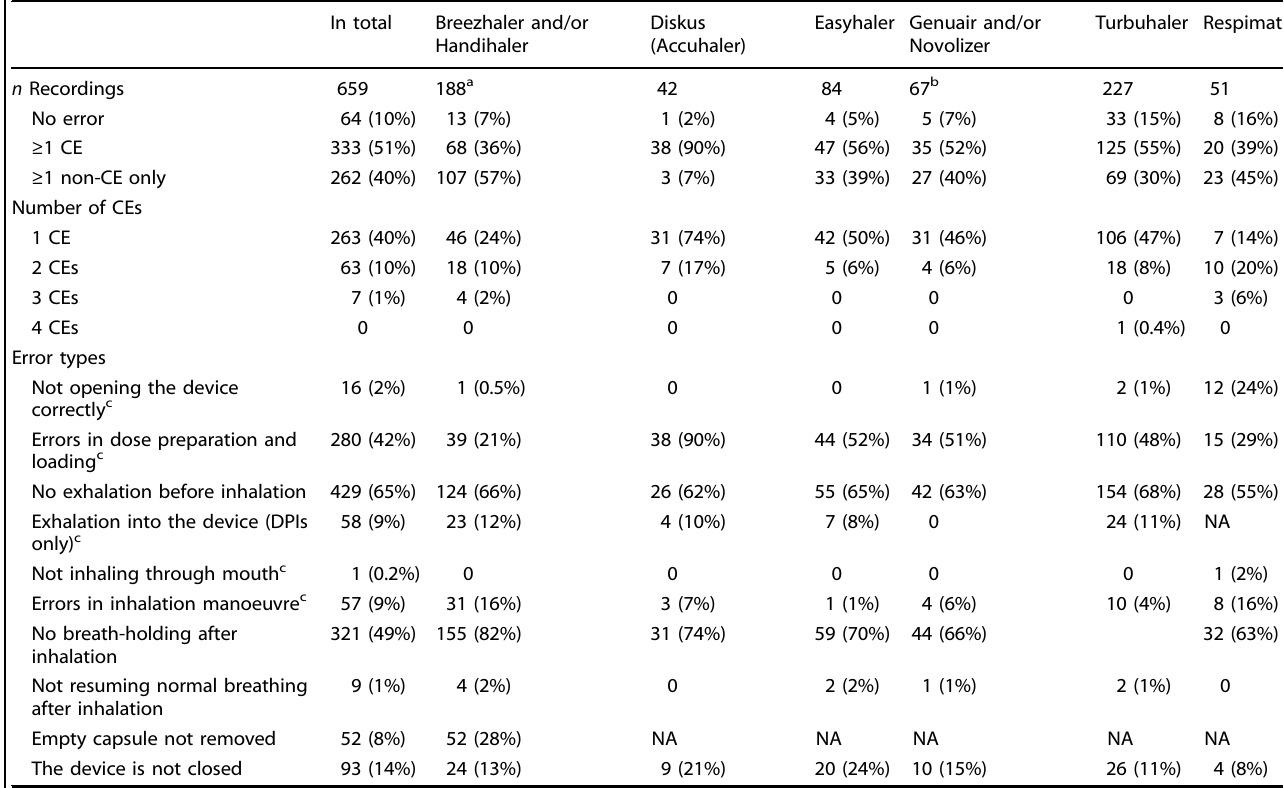
Table 2. Number (%) of recordings with critical errors (CEs) and types of errors in total and per inhaler device model.